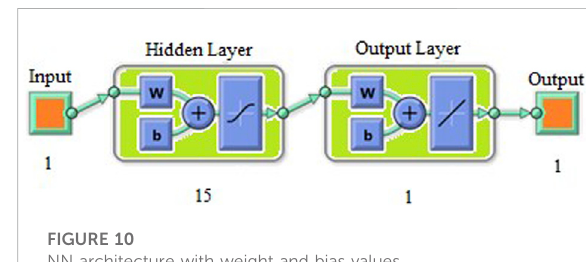
FIGURE 10 NN architecture with weight and bias